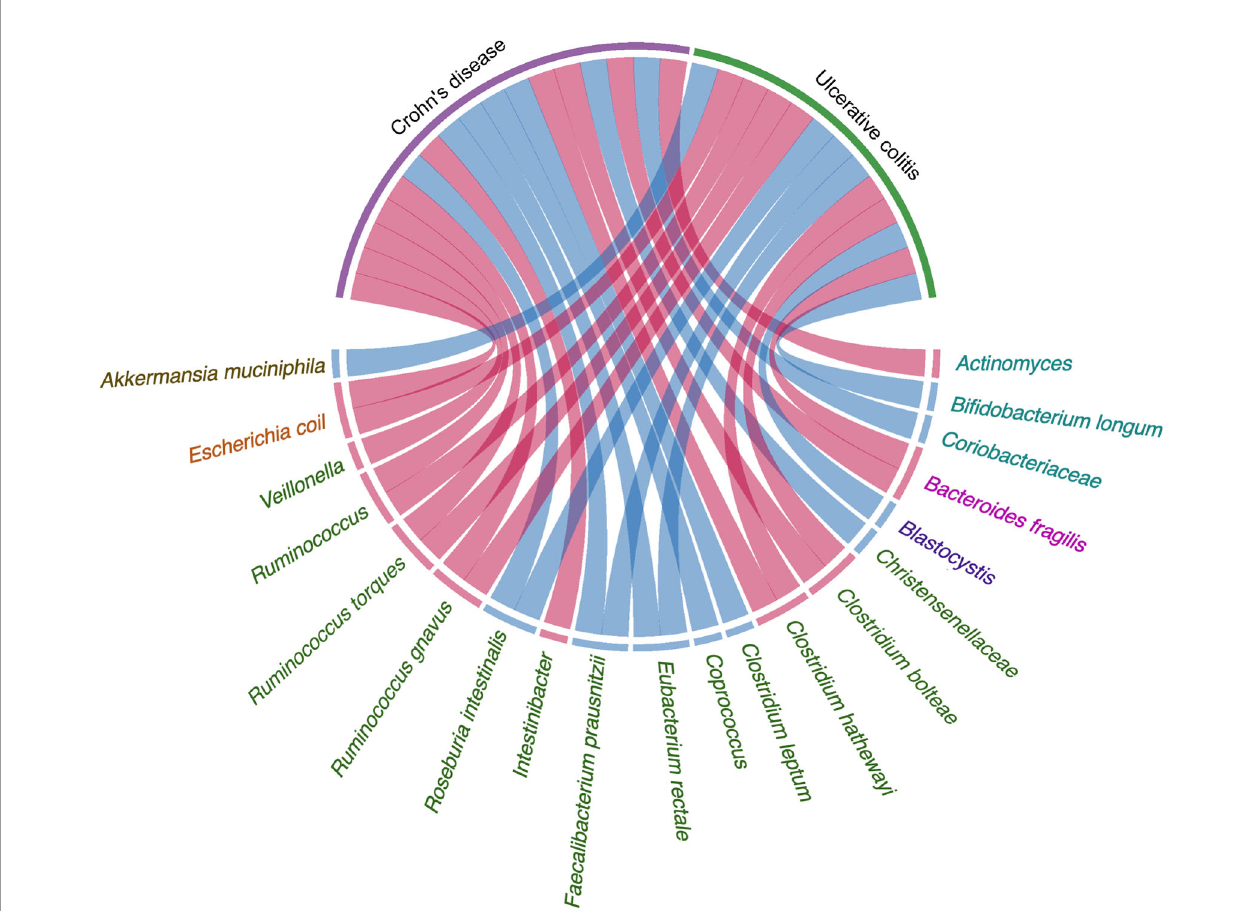
FIGURE 1 | Evidence of the gut microbiota enriched in UC and CD playing a vital role in pathogenesis. Circos plots showing the correlation of bacteria with pathogenesis in IBD. The red ribbons represent the higher production of bacteria enriched in IBD development. The blue ribbons represent the lower production of bacteria enriched in IBD. The causality of the microbiota in IBD has not yet been fully elucidated. Different taxa are divided into six groups and colored by the